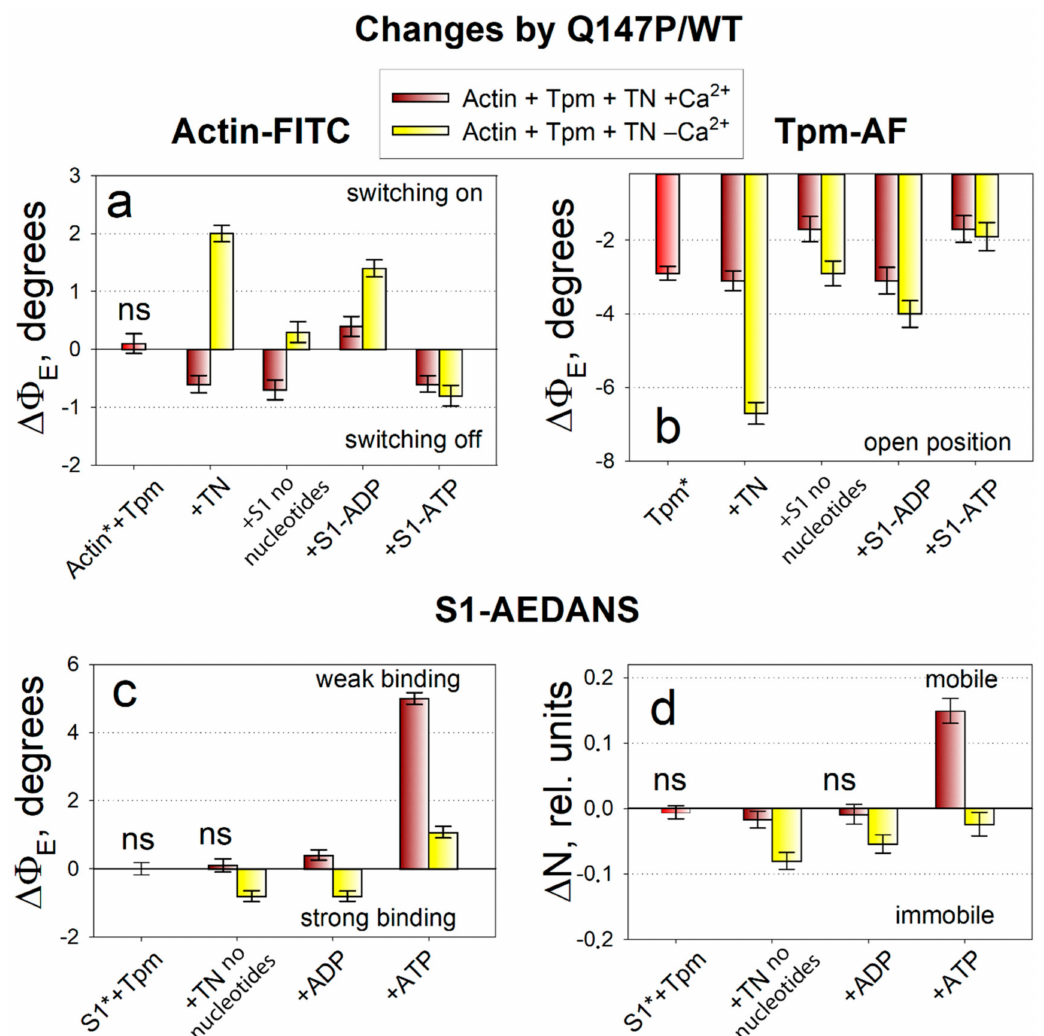
Figure 3. The e ff ect of the Q147P substitution in Tpm on the angles of orientation of emission dipoles Φ E for fluorescent probes associated with actin (Actin-FITC, or Actin*, a ), tropomyosin (Tpm-AF, or Tpm*, b ) and on the values of Φ E and relative number of disordered fluorophores N for fluorescent probe associated with S1 (S1-AEADANS, or S1*, c , d ) in ghost fibers containing reconstituted thin filaments with mutant recombinant Tpm and troponin (TN) at high (dark red columns) and low (yellow columns) Ca 2 + concentrations. The changes in the values are given relative to the WT Tpm (see Figure 1) in the same order and are significantly di ff erent (p < 0.05) except the values indicated as nonsignificant—ns. Red color is used for the values obtained in ghost fibers not containing troponin. An increase in the value of Φ E for actin-FITC occurs at switching actin on, while a decrease in the values of Φ E for Tpm-AF and S1-AEDANS is typical for the shift of Tpm towards the open position in actin groove and for increase in the number of the myosin heads in the strong-binding